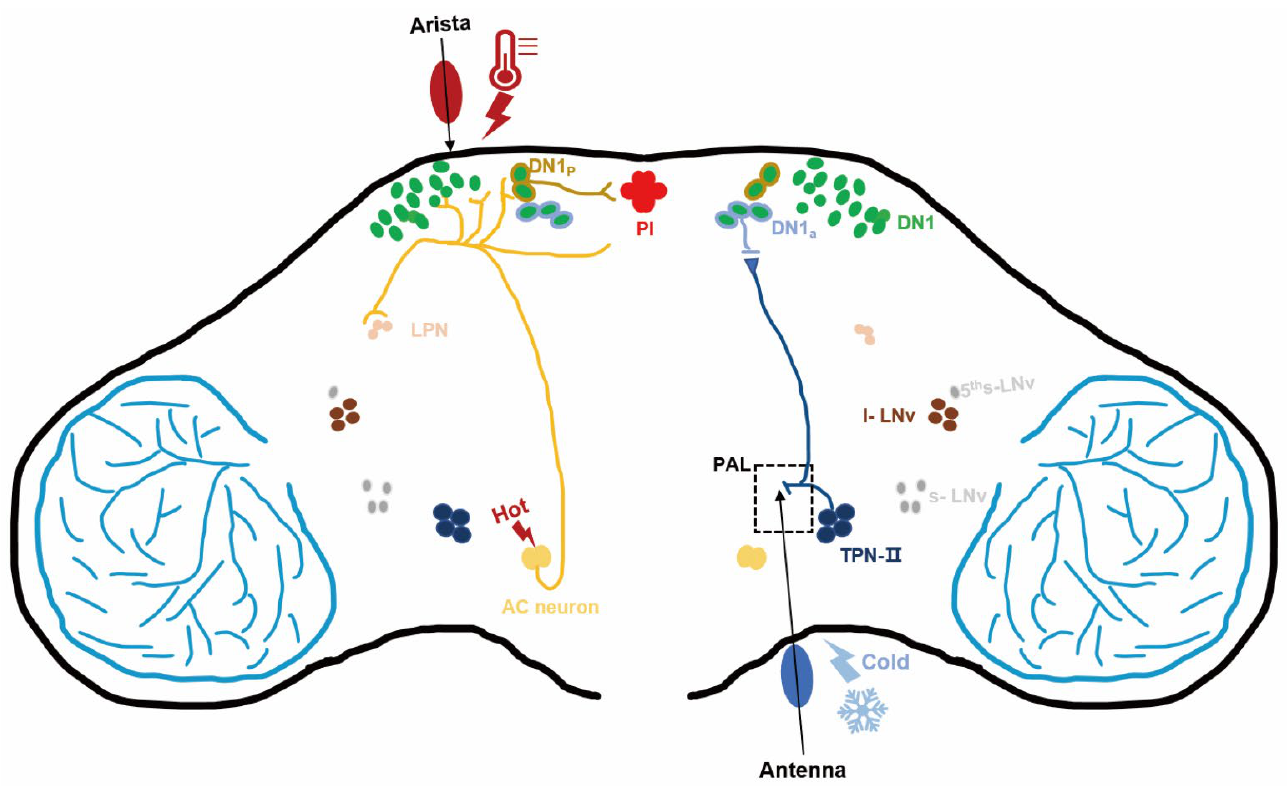
Figure 2. Thermoreceptor circuits in Drosophila . Some thermoreception and circadian neurons in the brain are shown in different colors. The antennae sense cold temperatures, and the second-order thermosensory projection neuron TPN-IIs transmit information from the posterior antennal lobe (PAL) to circadian neurons DN1a to regulate sleep in Drosophila . Arista and AC neurons sense warm temperatures and transmit information to some of the circadian neurons. One of the AC downstream neunon types, a subset of DN1ps (green circles with brown outline), transfers heat signals to PIs (red) to regulate sleep.